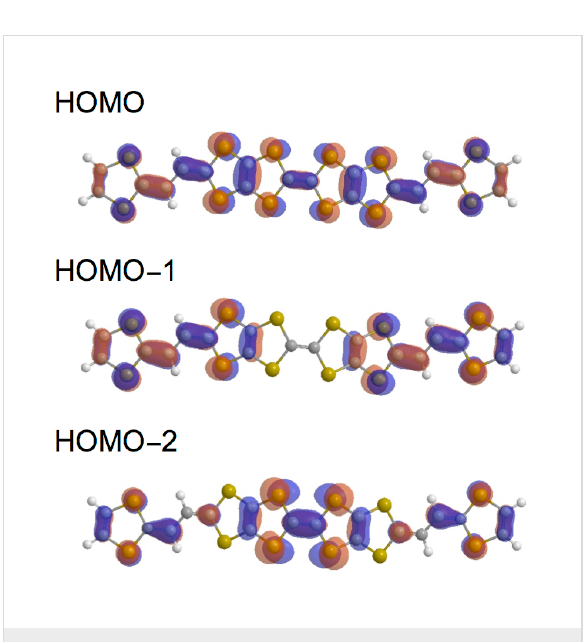
Figure 2: Molecular orbitals of 5a ( trans